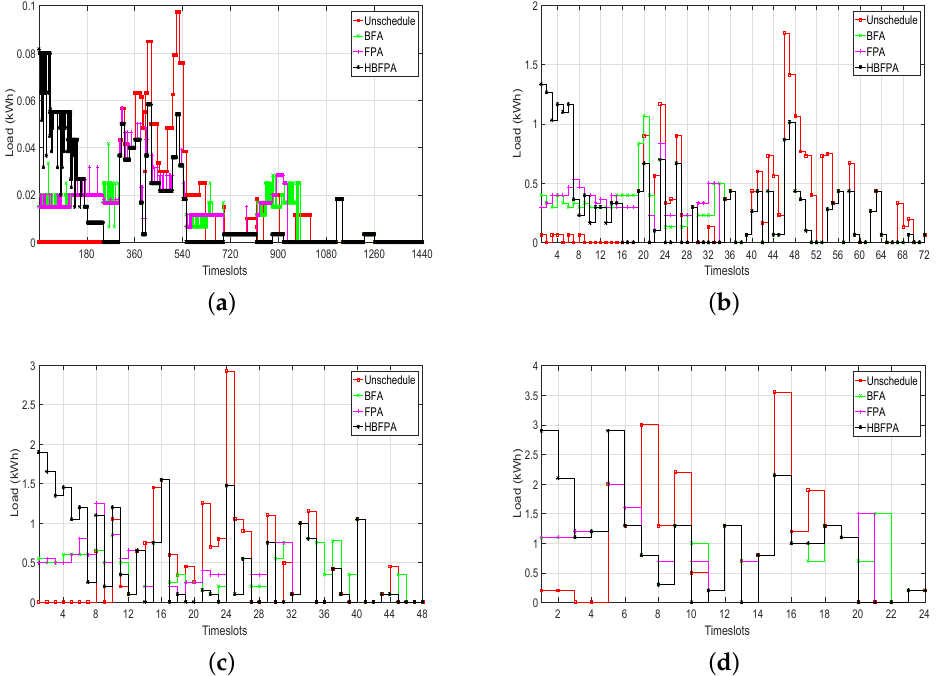
Figure 5. Load for single home using real time pricing. ( a ) load using operational time interval of 1 min; ( b ) load using operational time interval of 20 min; ( c ) load using operational time interval of 30 min; ( d ) load using operational time interval of 60